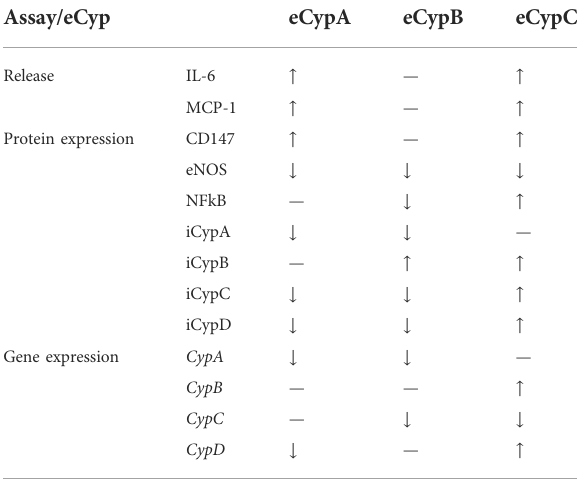
TABLE 2 Summary of eCyps effects in MS1